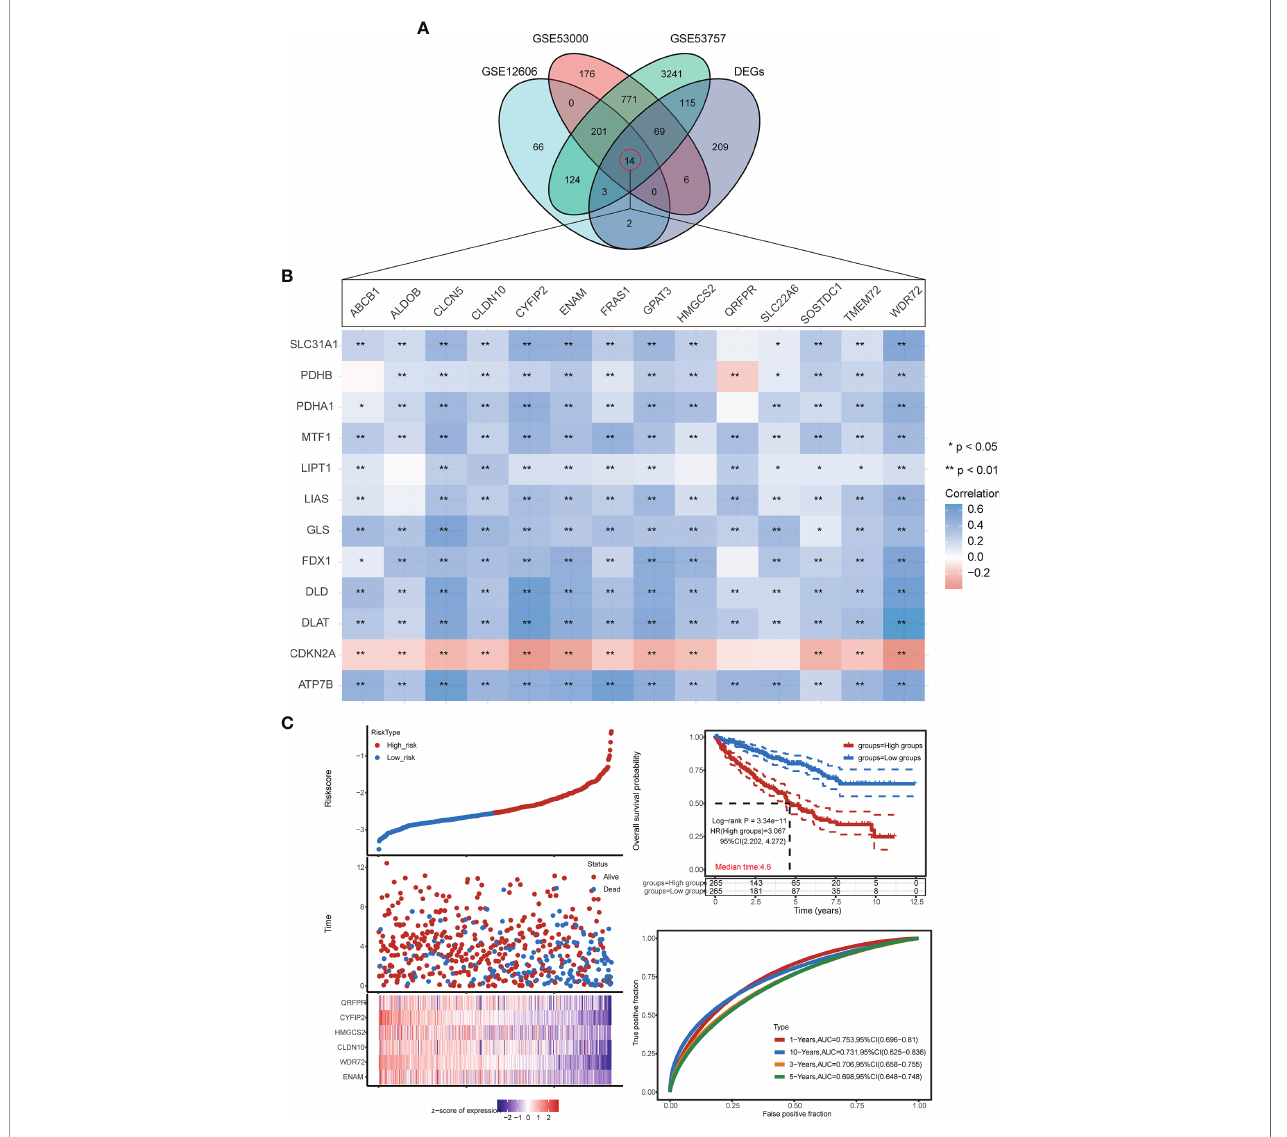
FIGURE 7 | Construction of the prognostic CRG score. (A) VN map shows the overlap of 4 datasets (G1/G2-DEGs, GSE12606, GSE53000, GSE53757). (B) Correlation heat map of 14 intersection genes and 12 CRGs. (C) Ranked dot and scatter plots showing the CRG score distribution and patient survival status, Kaplan – Meier analysis of the OS between the two groups. (h) ROC curves to predict the sensitivity and speci fi city of 1-, 3-, 5-, and 10-year survival according to the CRG score. *p < 0.05, **p <